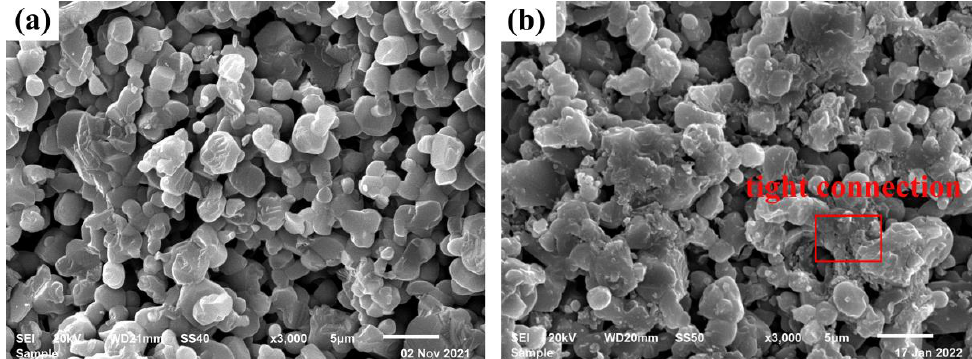
Figure 7. SEM images of B0.9 × 1000 °C ( a ) before corrosion and ( b ) after corrosion.